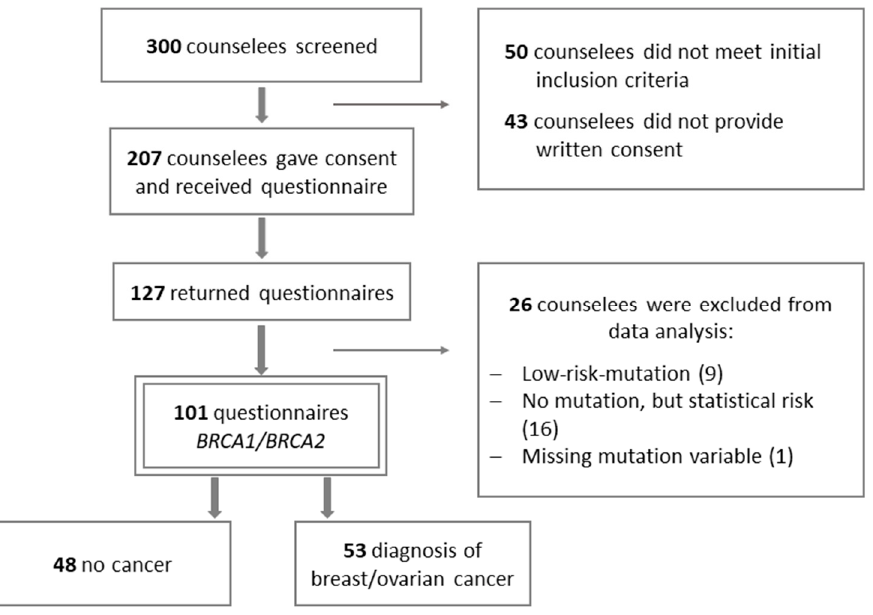
Figure 2. Flowchart of the study population.